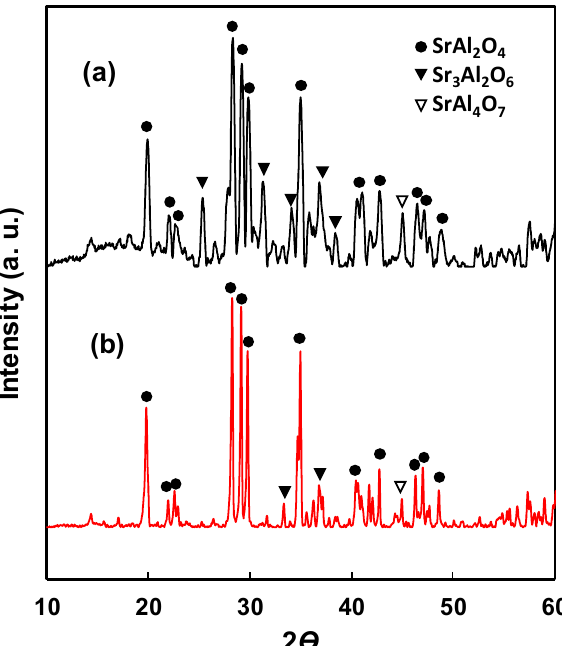
Figure 1. XRD patterns of strontium aluminates (SAO) synthesized by ( a ) hydrothermal reaction and ( b ) sol–gel method.